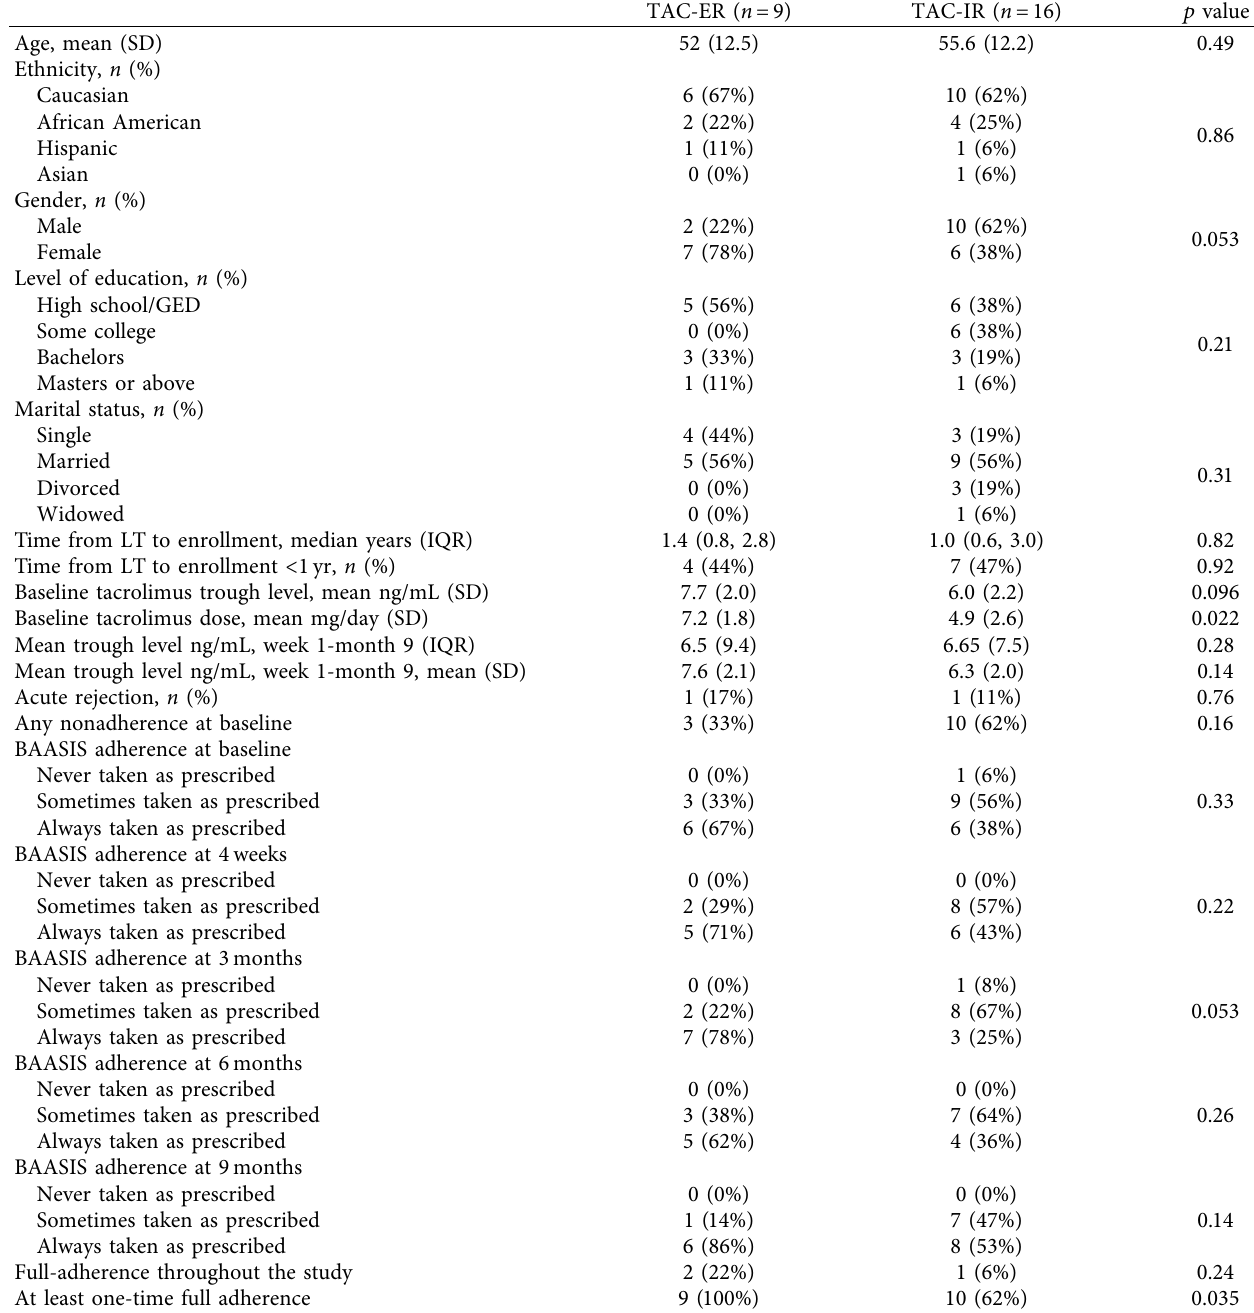
Table 1: Baseline demographics, clinical characteristics, and medication adherence of the study